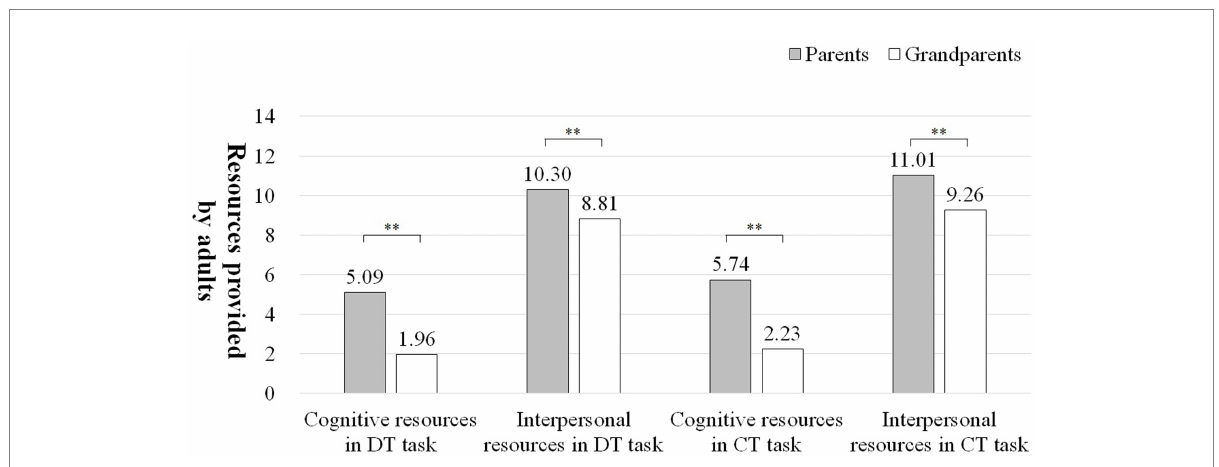
FIGURE 2 Comparisons of the cognitive resources and interpersonal resources given to children by parents and grandparents. ** indicates that the difference is significant at the 0.01